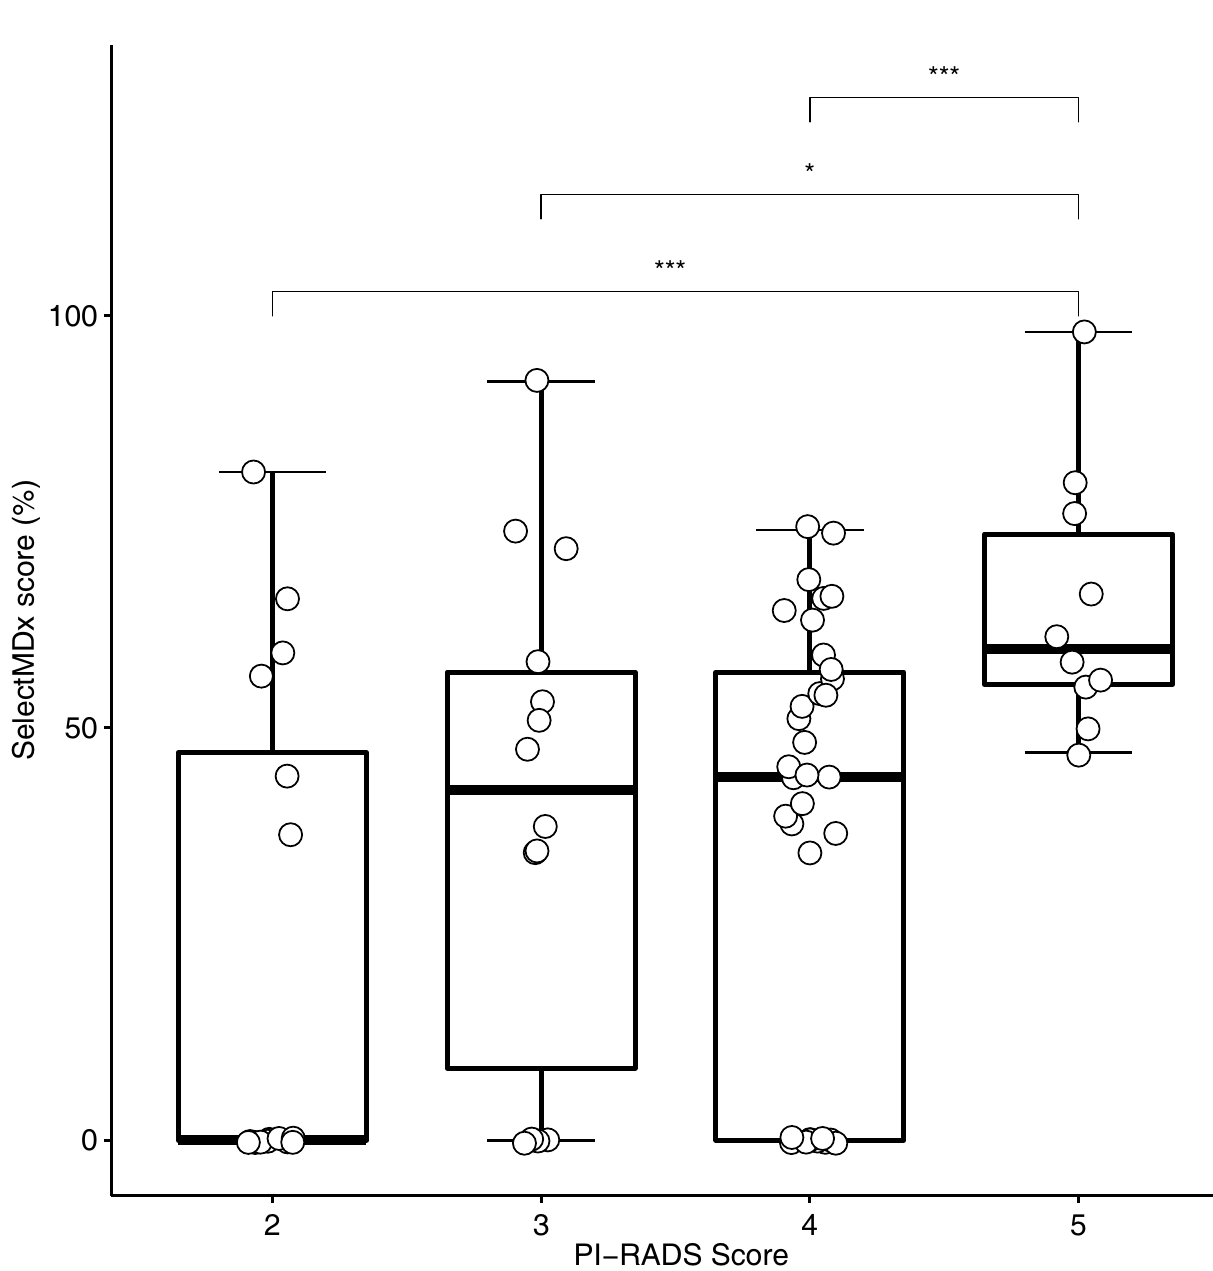
Fig 3. Box plot depicting SelectMDx 1 scores for different PI-RADS scores. Each paired boxplot with a statistically significance in means, was indicated using asterisks with the following, standardized significance codes: � p � 0.05, �� p � 0.01, ��� p � 0.001. The differences in means of SelectMDx 1 results according to PI-RADS Scores 2–5 were significant in ANOVA (p =